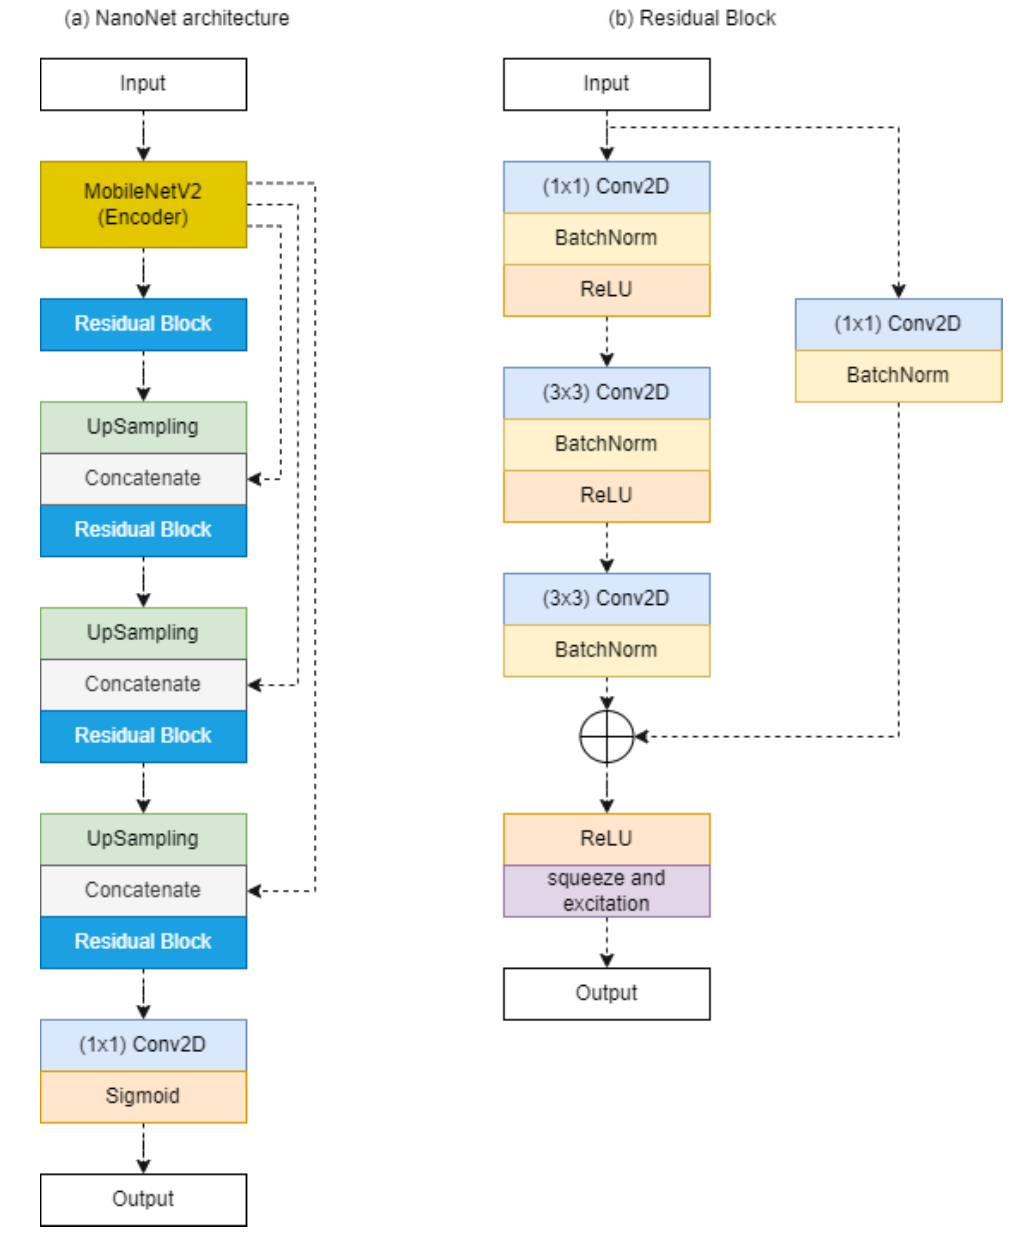
Figure 4. NanoNet architecture (adapted from